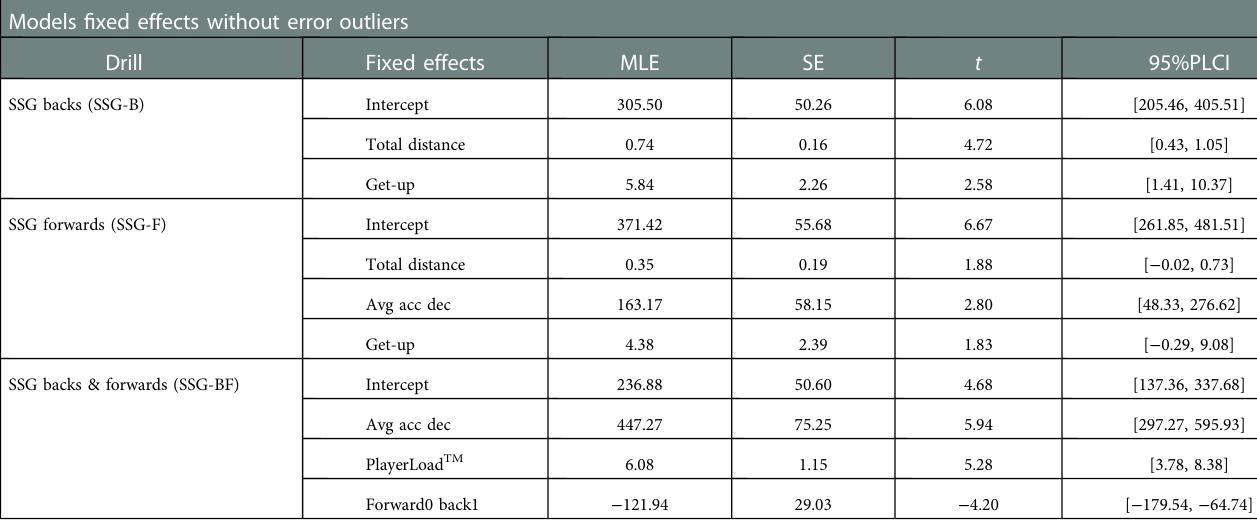
TABLE 5 Fixed effects of the models without error outliers for the three small-sided game designs. Models fi xed effects without error